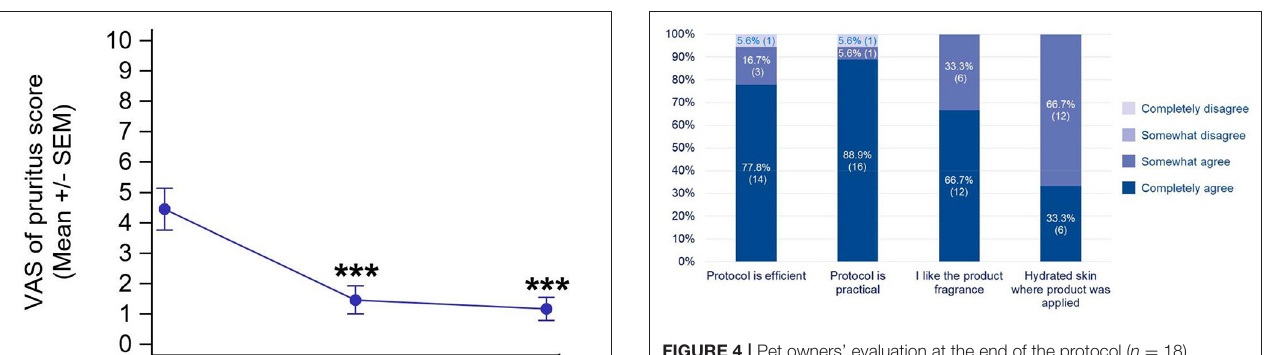
FIGURE 4 | Pet owners’ evaluation at the end of the protocol ( n =